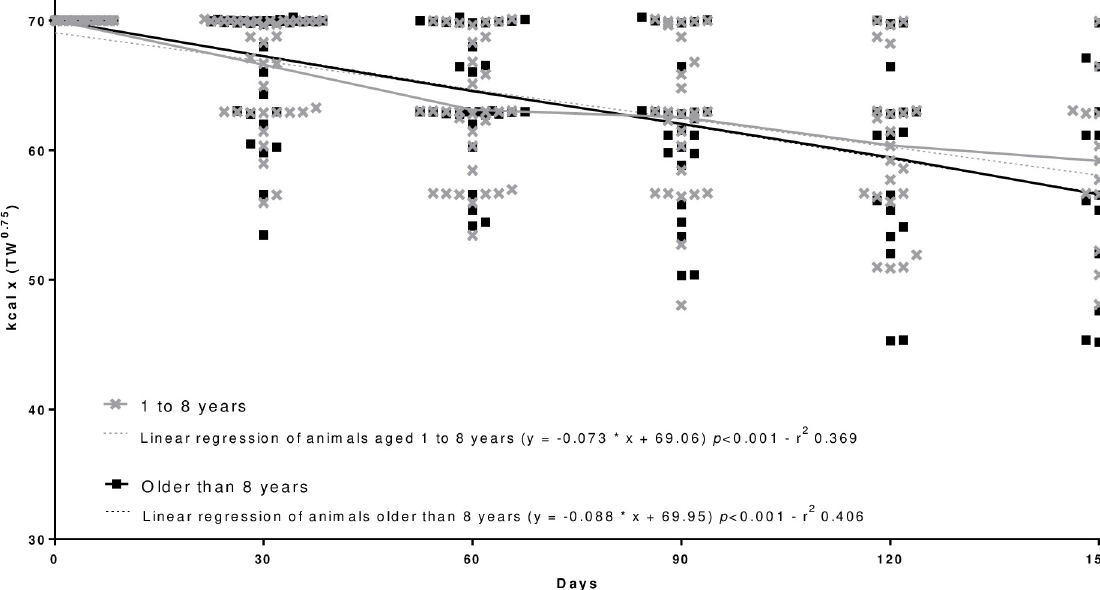
Fig 3. Regression analysis and complete distribution of the calories (kcal) applied to the weight loss equation [kcal x (TW 0.75 )] according with age.